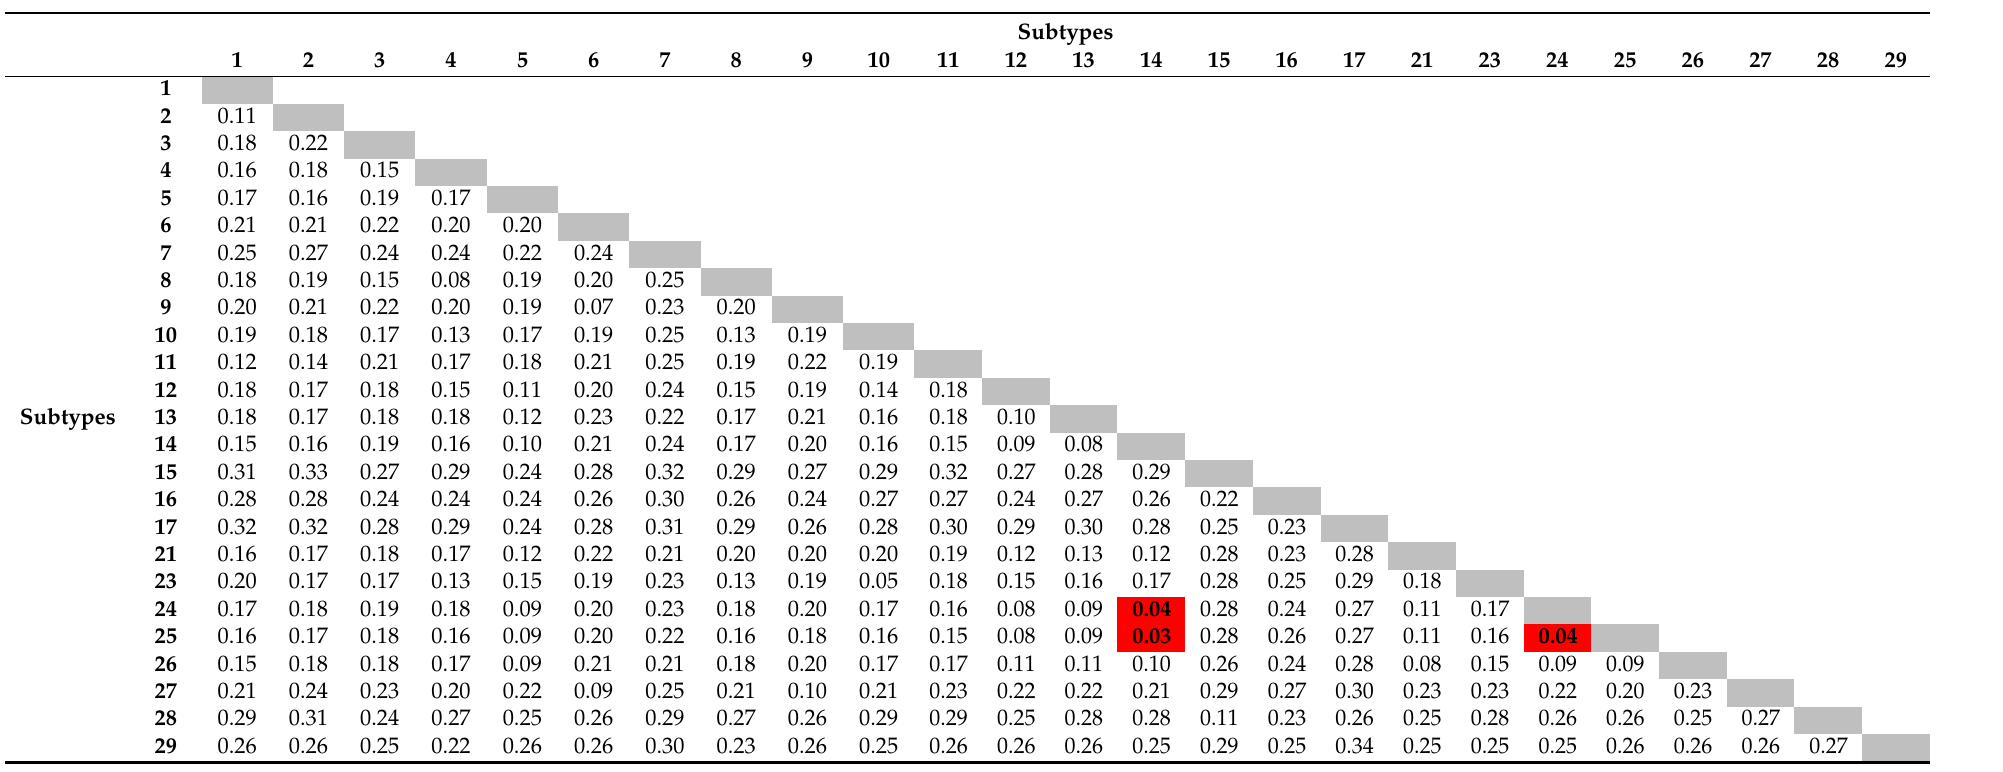
Table 5. Pairwise distances between Blastocystis subtypes Santin region sequences showing the number of base substitutions per site between sequences. Analyses were conducted using the Kimura 2-parameter model and included 64 nucleotide sequences (Table 2). There were a total of 568 positions in the final dataset. Red background indicates pairwise distance lower than